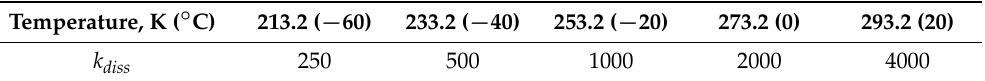
Table 2. Dissipation coefficient adopted for 17Mn1Si steel at different temperatures.